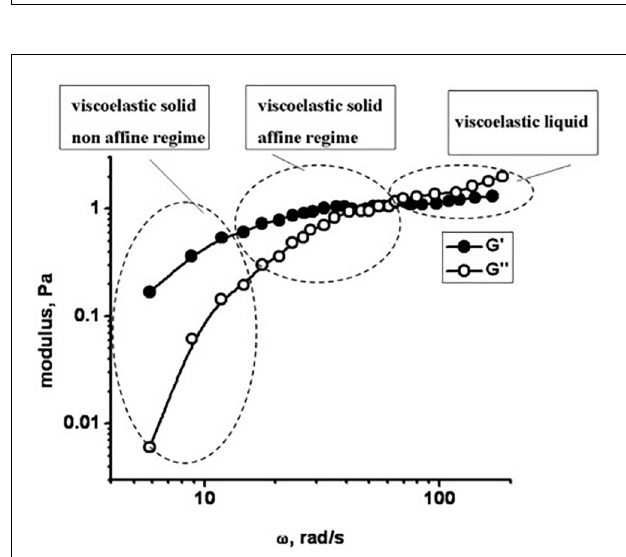
FIGURE 3 | Viscoelasticity of RBC obtained by the microrheological measurements: Storage and loss moduli (G’ and G”) vs. angular velocity.